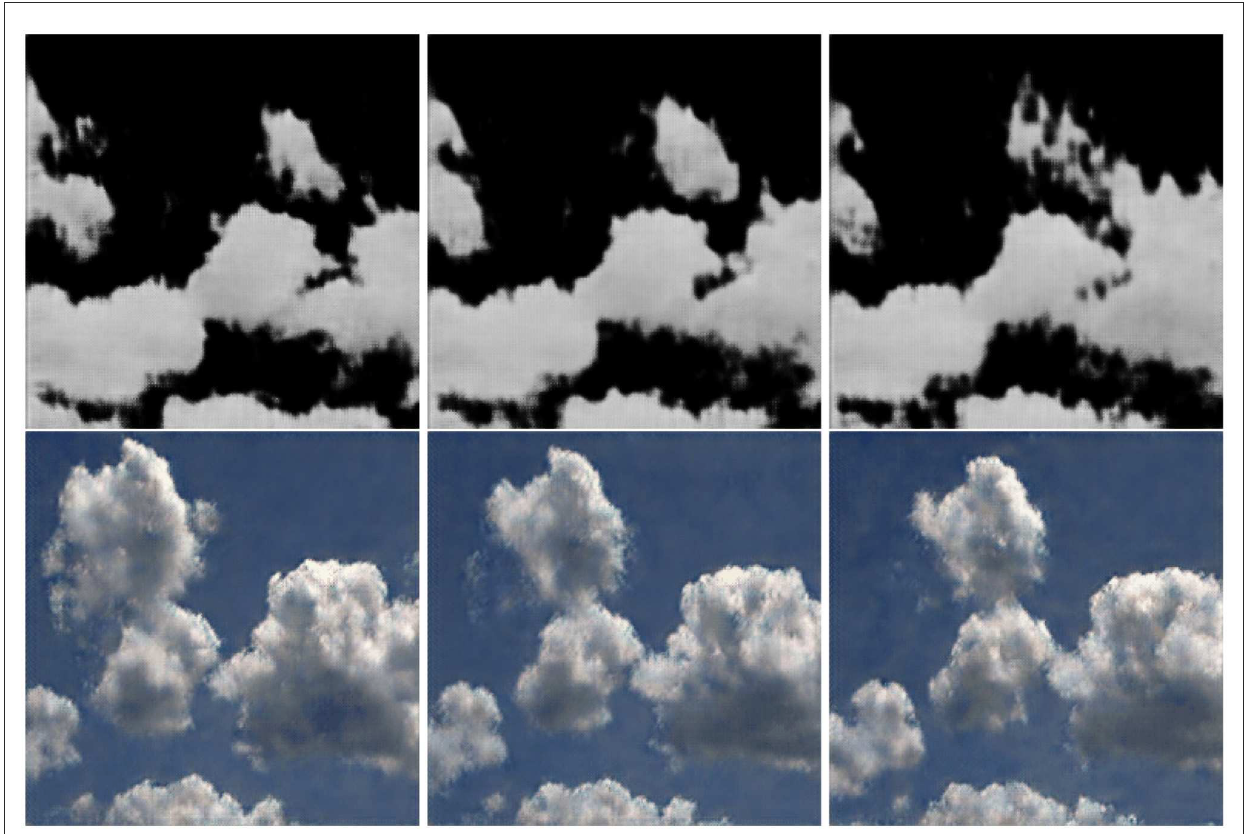
FIGURE10 Images generated by models based on T_DCGAN trained on cloud maps (top) and real-life clouds (bottom) . Columns represent three different inputs which could be seen as three different timestamps, with no direct correlation to real